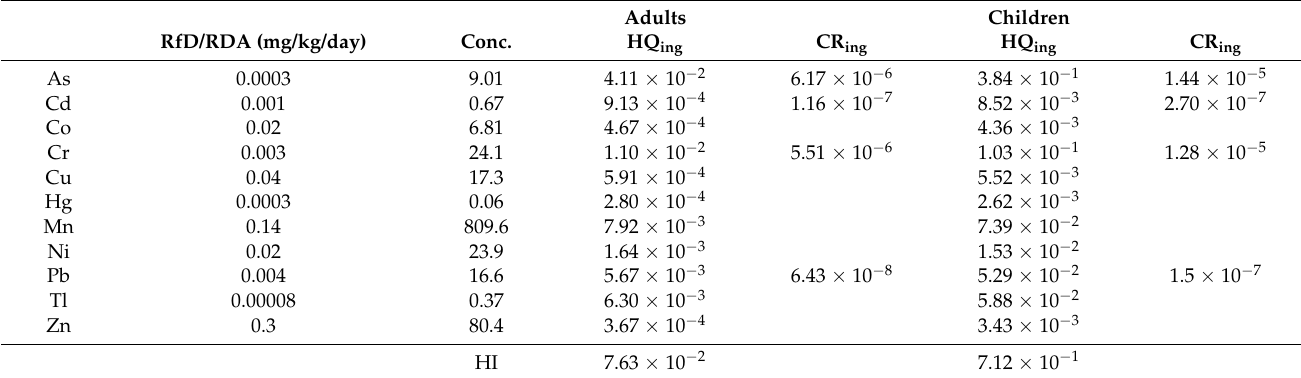
Table 4. Description of health risk assessment for heavy metals in